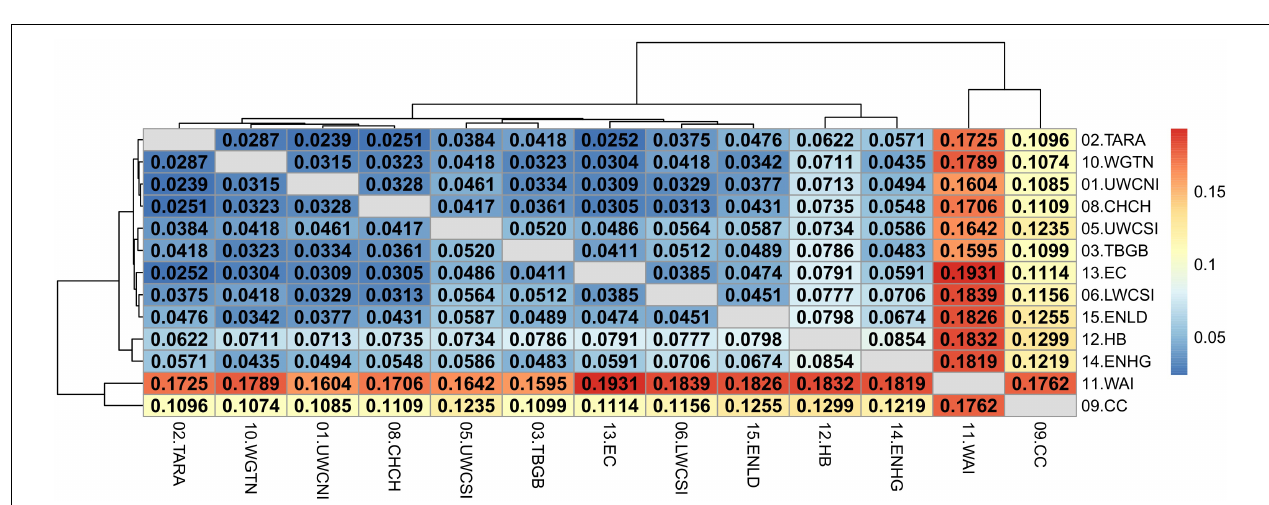
FIGURE 8 | Heatmap of pairwise weighted F ST estimates (corresponding to the values above and below the diagonal) among sample locations of the neutral SNP dataset, minus Tasmania. The dendrogram shows the inferred relationship between sample locations. Significant p -values ( ≤ 0.05 after false discovery rate correction) are in bold.